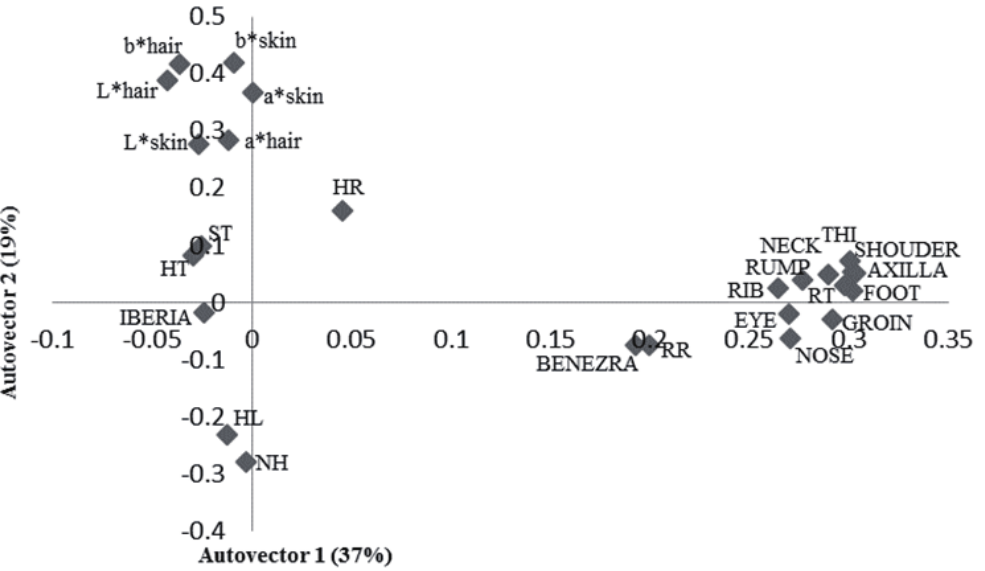
Figure 2. First two autovectors for heat tolerance indices, thermograph temperatures and physiological and physical traits in sheep in the Federal District, Brazil. RT, rectal temperature (°C); HR, heart rate (beats/min); RR, respiratory rate (movements/minute); ST, skin thickness; HT, hair thickness; NH, number of hairs; HL, length of hair; L * , brightness; chromatic channels representing b * , yellow-blue; a * , red-green